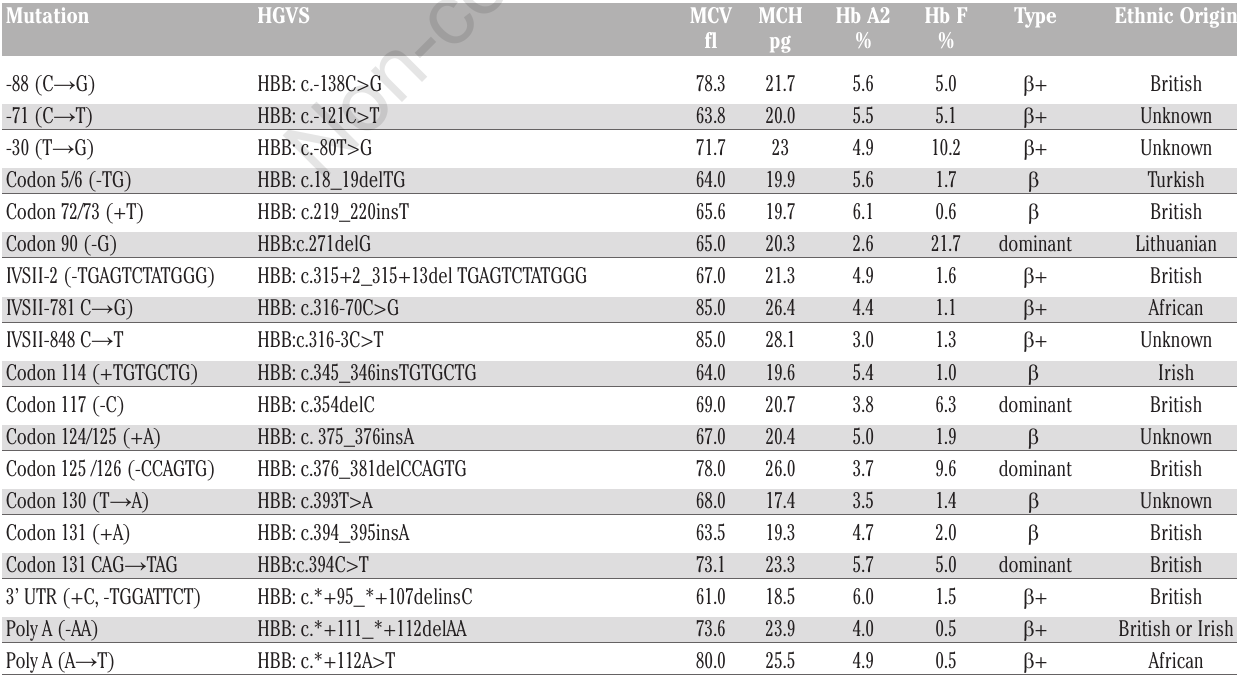
Table 1. Novel β -thalassaemia mutations and some haematological findings.